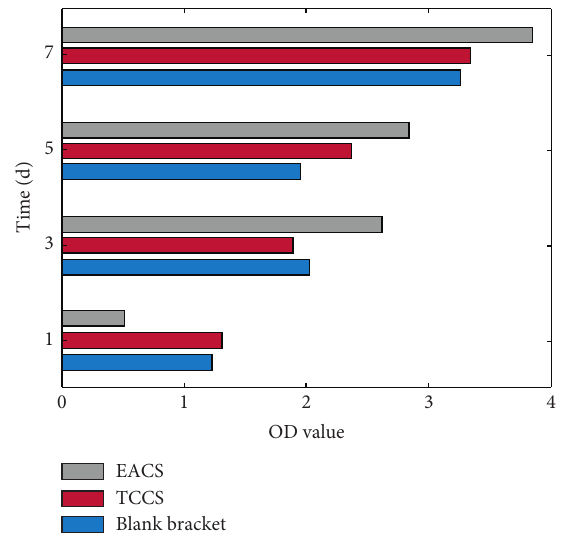
Figure 1: Proliferation of BMSCs on blank stents, TCS, and